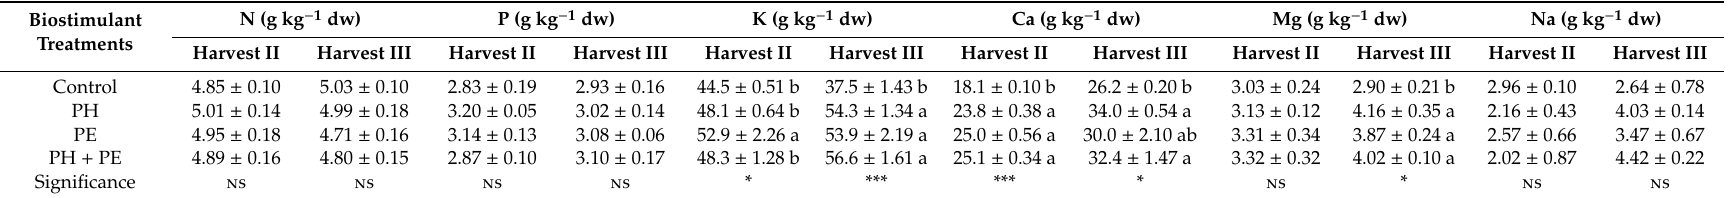
Table 3. E ff ect of foliar applications of protein hydrolysates (PH) and tropical plant extract (PE) alone or in combination on leaf mineral composition of greenhouse cultivated perennial wall